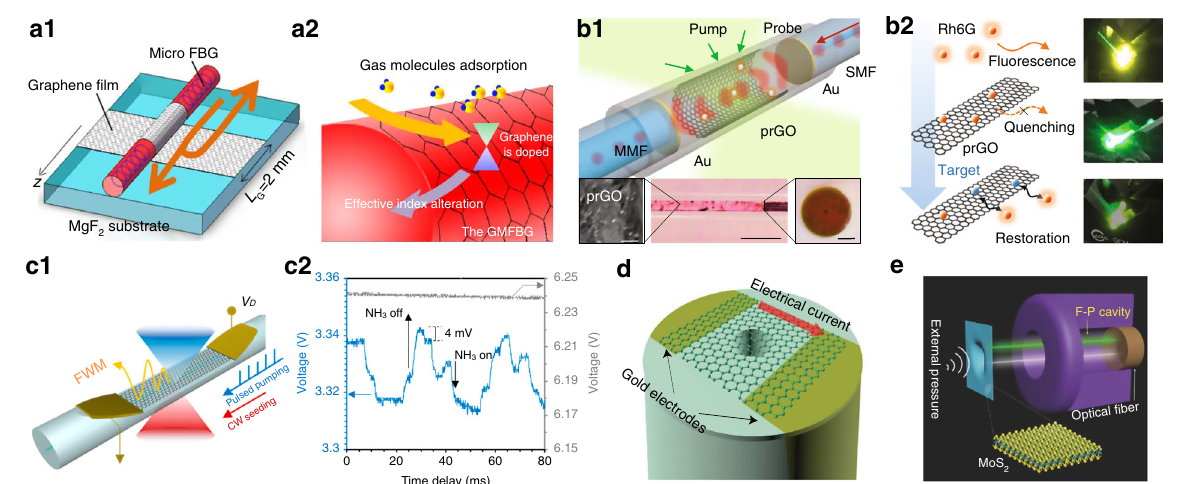
Fig. 7 Optical fi ber sensors with 2D materials. Structure of graphene-coated micro fi ber-based Bragg grating ( a1 ) and its molecules sensing principle ( a2 ) 48 . b1 Photonic biosensor by depositing partially reduced graphene oxide (prGO) on a micro fl uidic dye resonator. Inset: Microscopic pictures of the devices 53 . b2 Fluorescent resonance energy transfer sensing mechanism 53 . Electrically tunable four-wave-mixing in graphene-D- shaped- fi ber ( c1 ) for individual gas molecule (NH 3 ) on/off dynamics detection ( c2 ) 54 . d Miniature optical fi ber current sensor based on a free-standing graphene with two gold electrodes on the pre-etched fi ber tip 51 . e Schematic illustration of the F-P pressure sensor based on few-layer MoS 2 and its working mechanism 178 . a1 – a2 Reproduced from ref. 48 with the permission of OSA Publishing. b1 – b2 From ref. 53 . Reproduced by permission of Springer Nature: Light: Science & Applications. c1 – c2 Reproduced from ref. 54 with permission from ACS Publications. d From ref. 51 . Copyright 2015, Wiley-VCH. e Reproduced from ref. 178 . Copyright 2016,